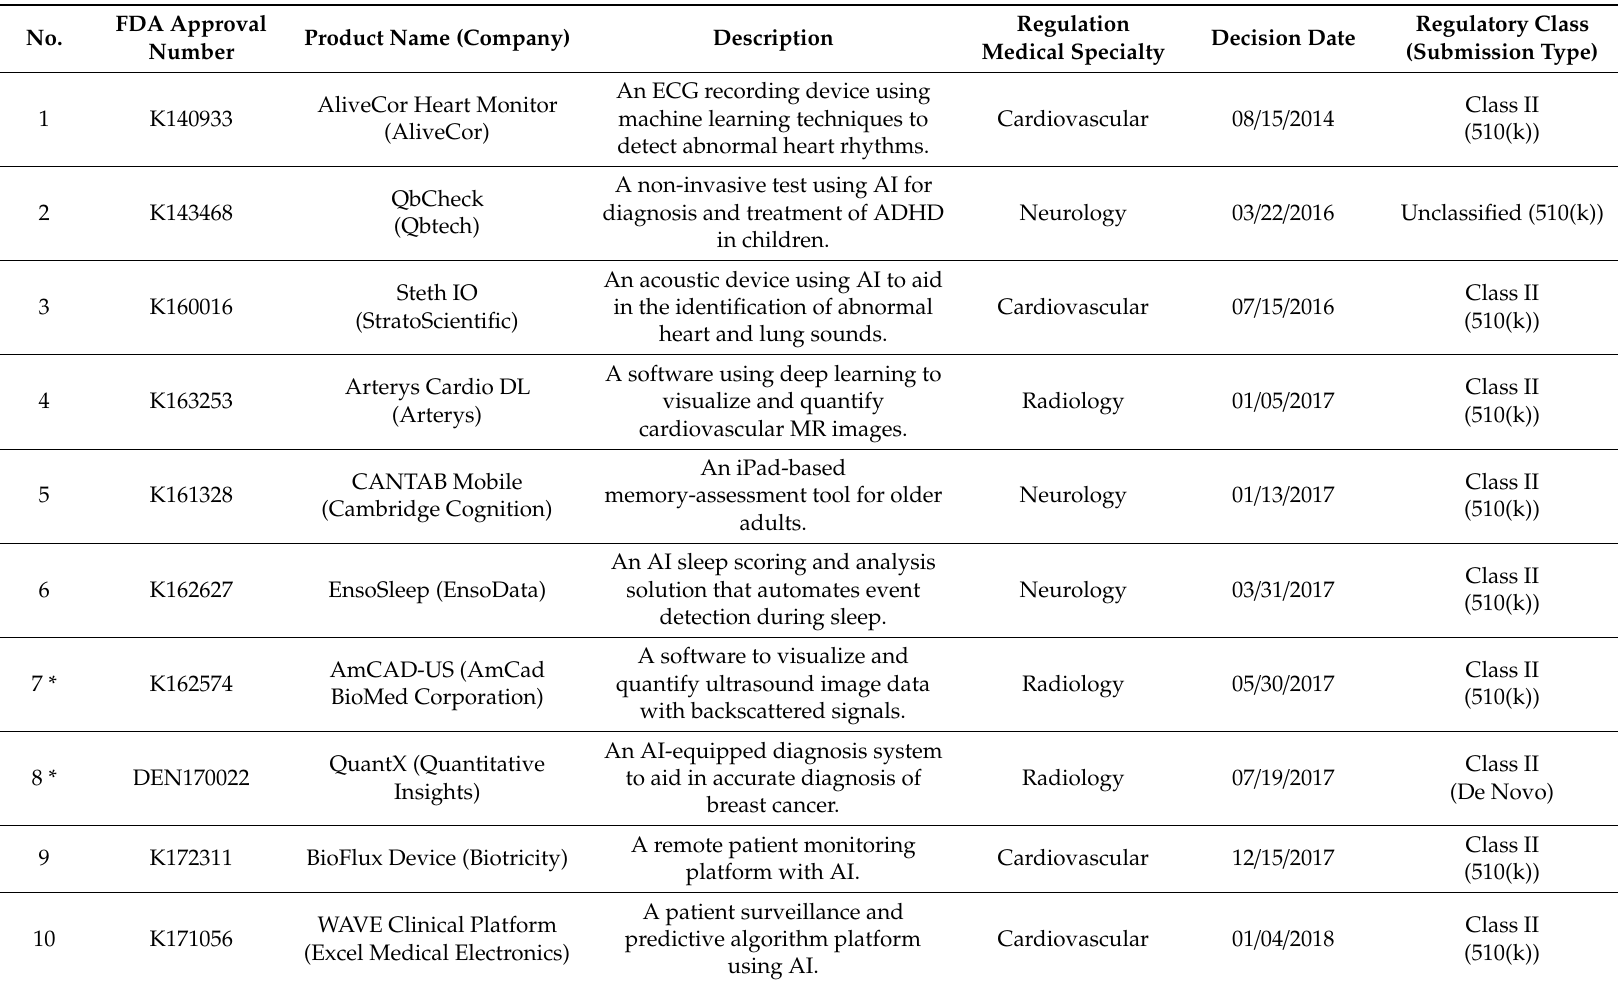
Table 1. List of AI-equipped medical devices approved by the US